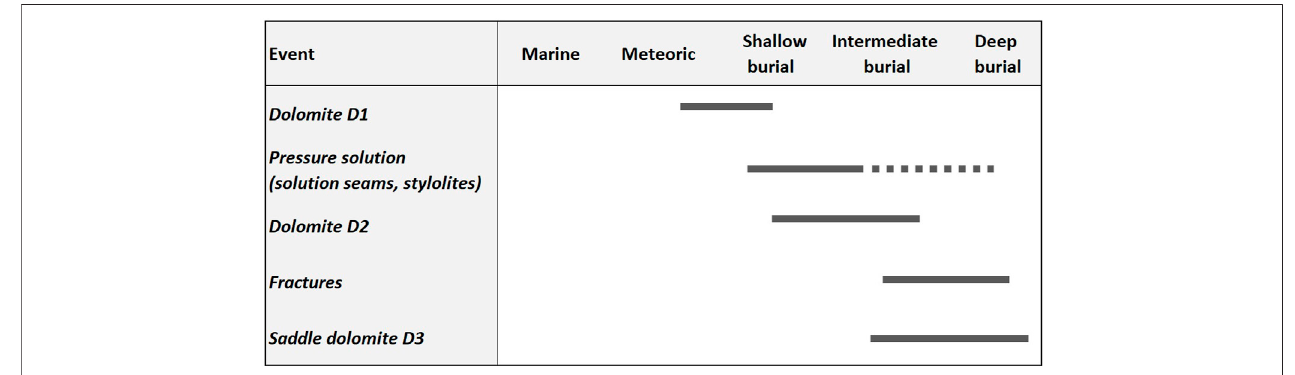
FIGURE 2 | Paragenetic sequence of major diagenetic processes that affected the investigated Middle – Upper Cambrian Xixiangchi carbonates, according to petrographic observations.